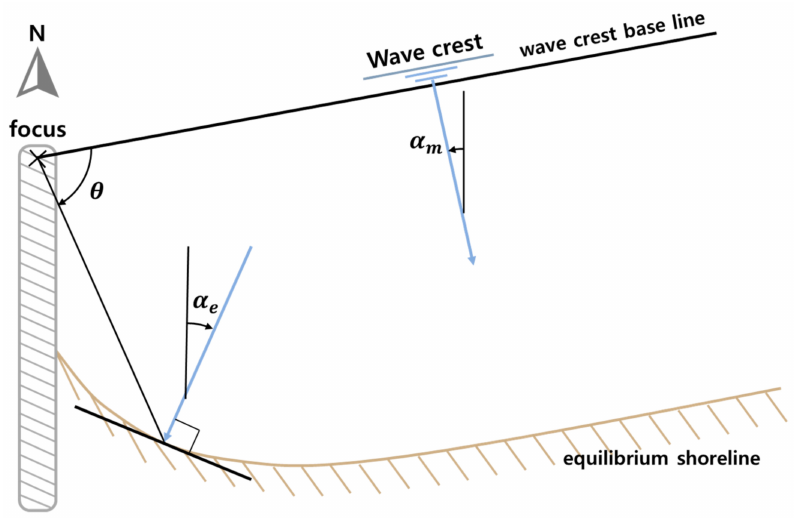
Figure 3. Definition sketch of annual mean wave angle and gradient of equilibrium shoreline.